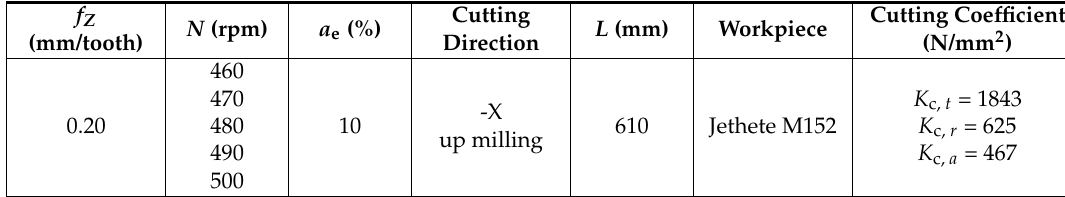
Table 5. Process conditions for new flip lobe family observation.